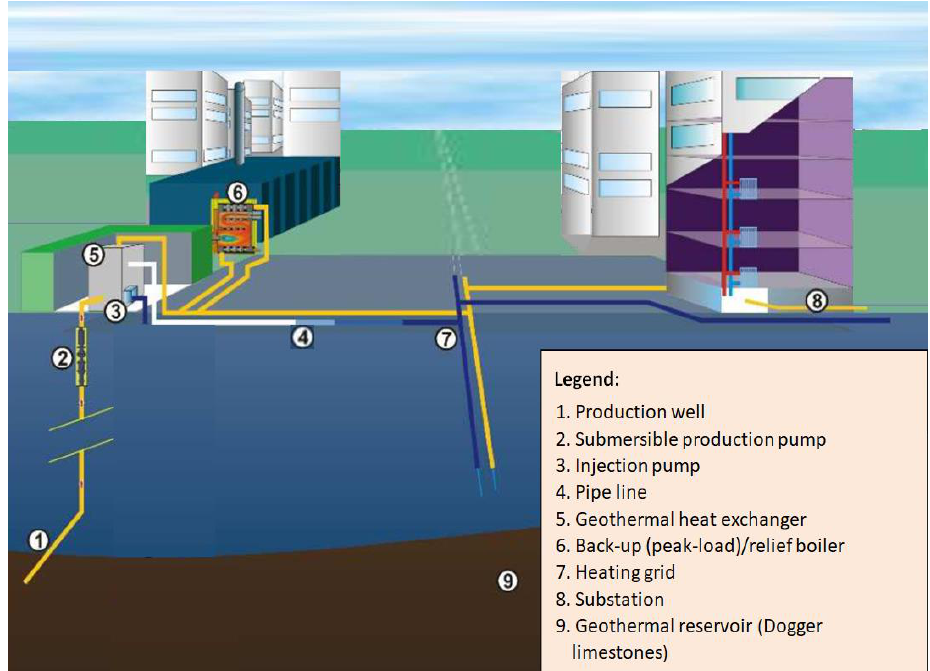
Figure 3 . Scheme of district heating using geothermal energy. Figure 3. Scheme of district heating using geothermal